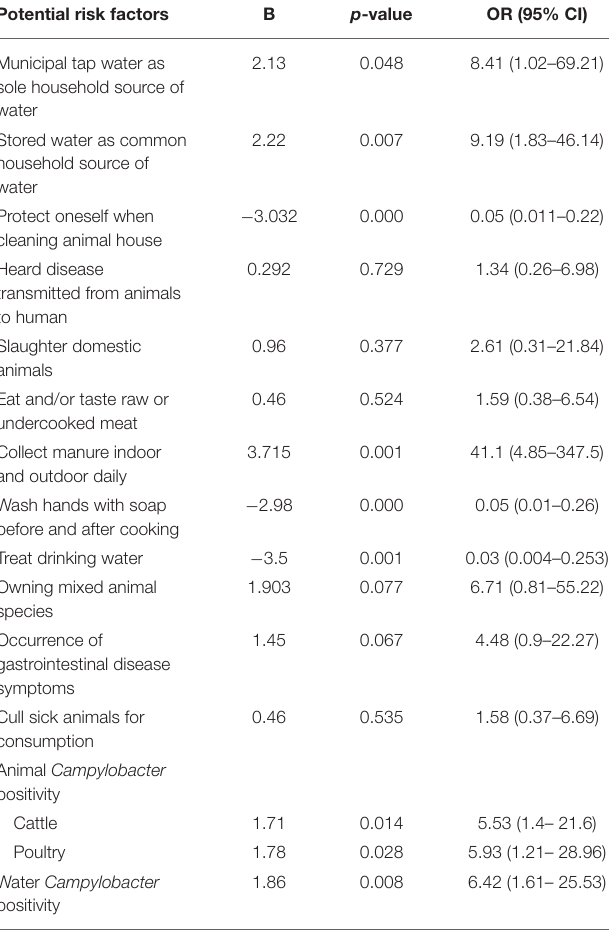
TABLE 3 | Univariable logistic regression analysis of potential risk factors for human Campylobacter species positivity. Potential risk